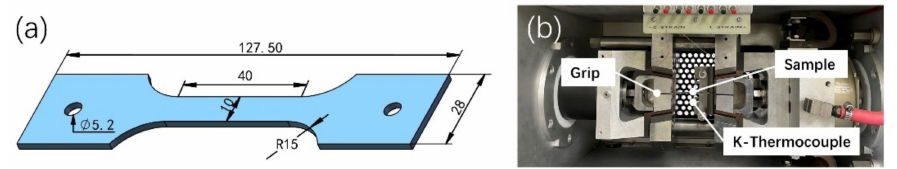
Figure 2. ( a ) Sketch of the elevated-temperature tension testing specimen (units in mm), ( b ) Schematic diagram of the elevated-temperature tension test.